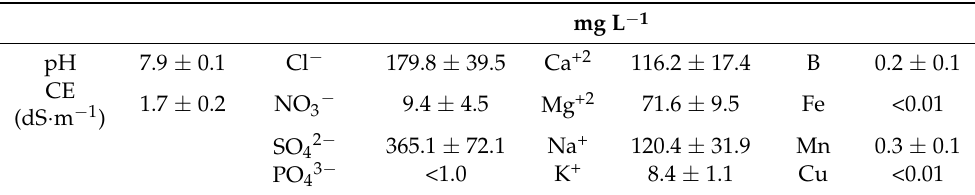
Table 1. Chemical composition of the water used for irrigation. Data shown are average values from several samples collected during the entire experimental